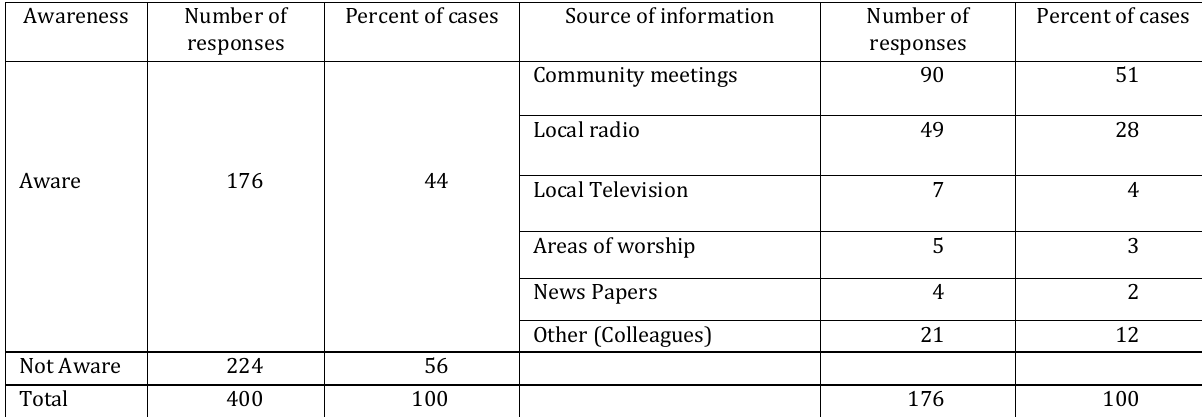
Table 3. Respondents’ Awareness and Sources of Information obtained by the Respondents Concerning Wetland Conservation in the Study Areas, Author’s questionnaire survey Awareness Number of Percent of cases Source of responses